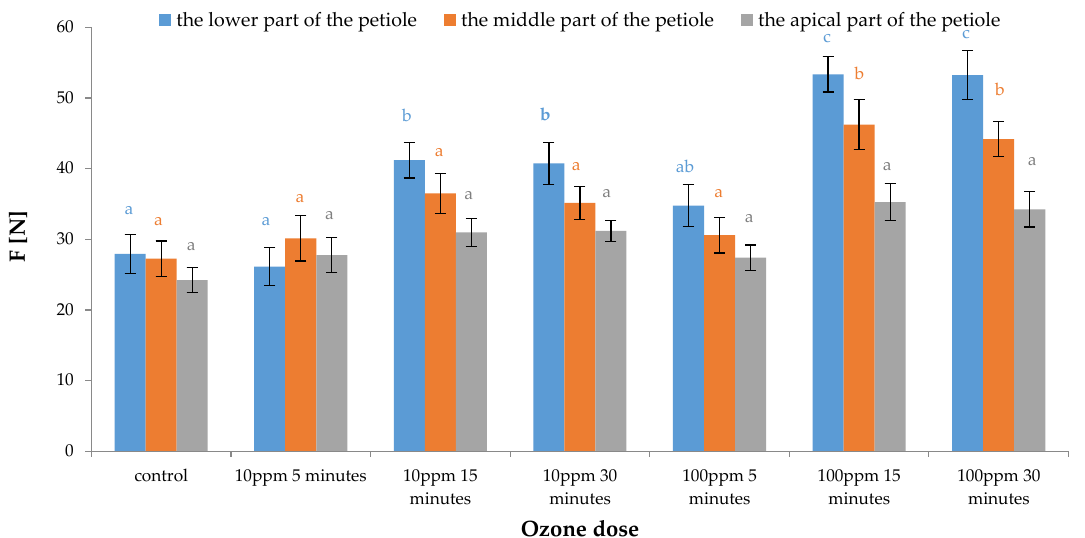
Figure 4. Mean values of destructive force identified for the specimens ϕ = 4 mm cut out transversely to the axis of rhapontic rhubarb petioles. Di ff erences in the results between the values of the destructive force for individual variants are marked with di ff erent small letters, p < 0.05.